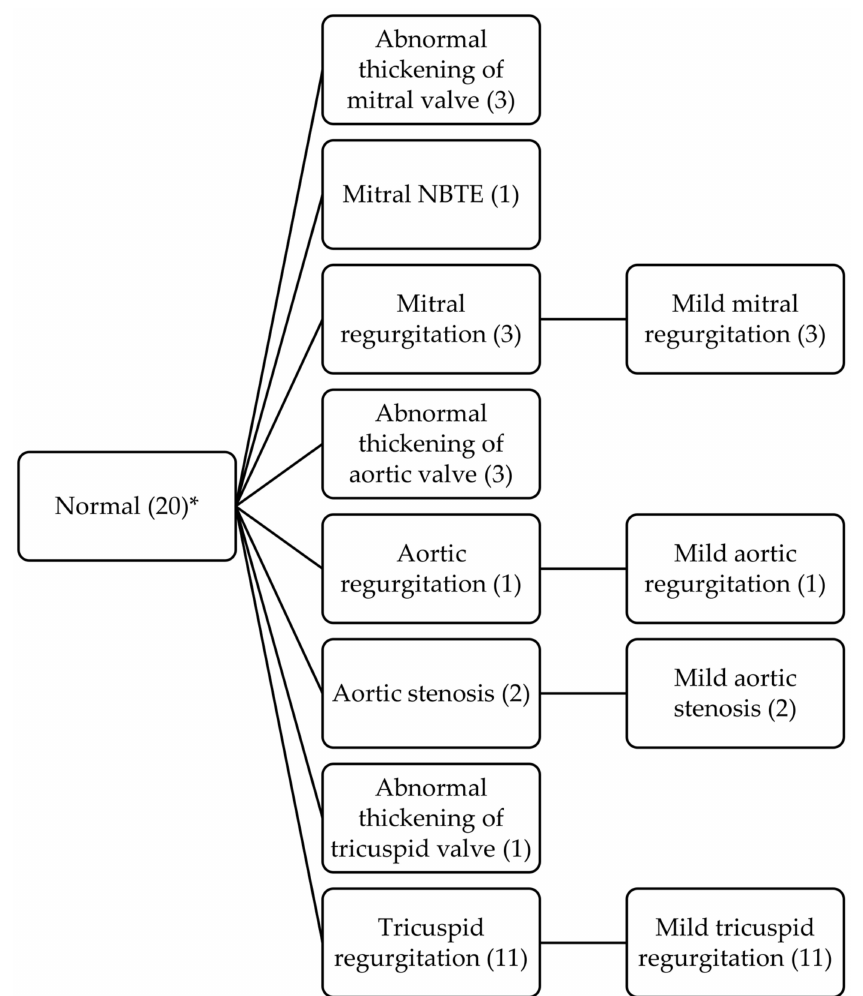
Figure 3. Timeline diagram with evolutive changes of normal valves. * More than one valvular lesion or dysfunction occurred in the same patient. Abbreviations: NBTE: non-bacterial thrombotic